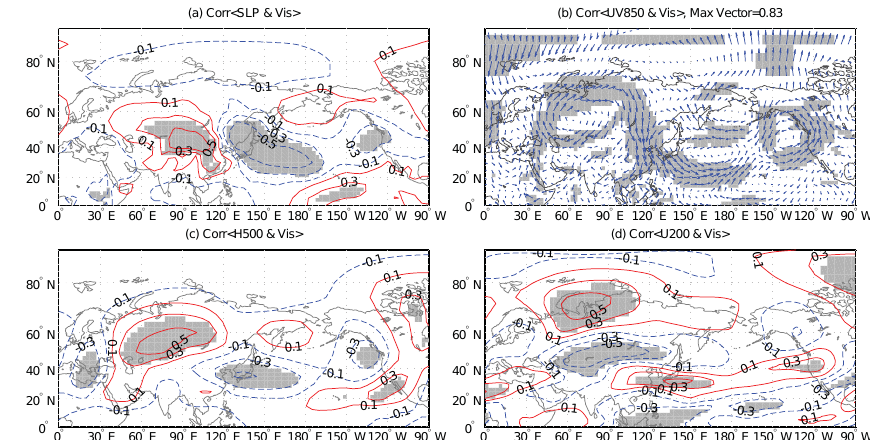
Figure 3. Spatial distribution of correlation coefficients between visibility and SLP (a) , UV850 (b) , H500 (c) and U200 (d) (areas significant at the 0.05 level are shaded; either U850 or V850 significant at the 0.05 level are shaded in (b) ).